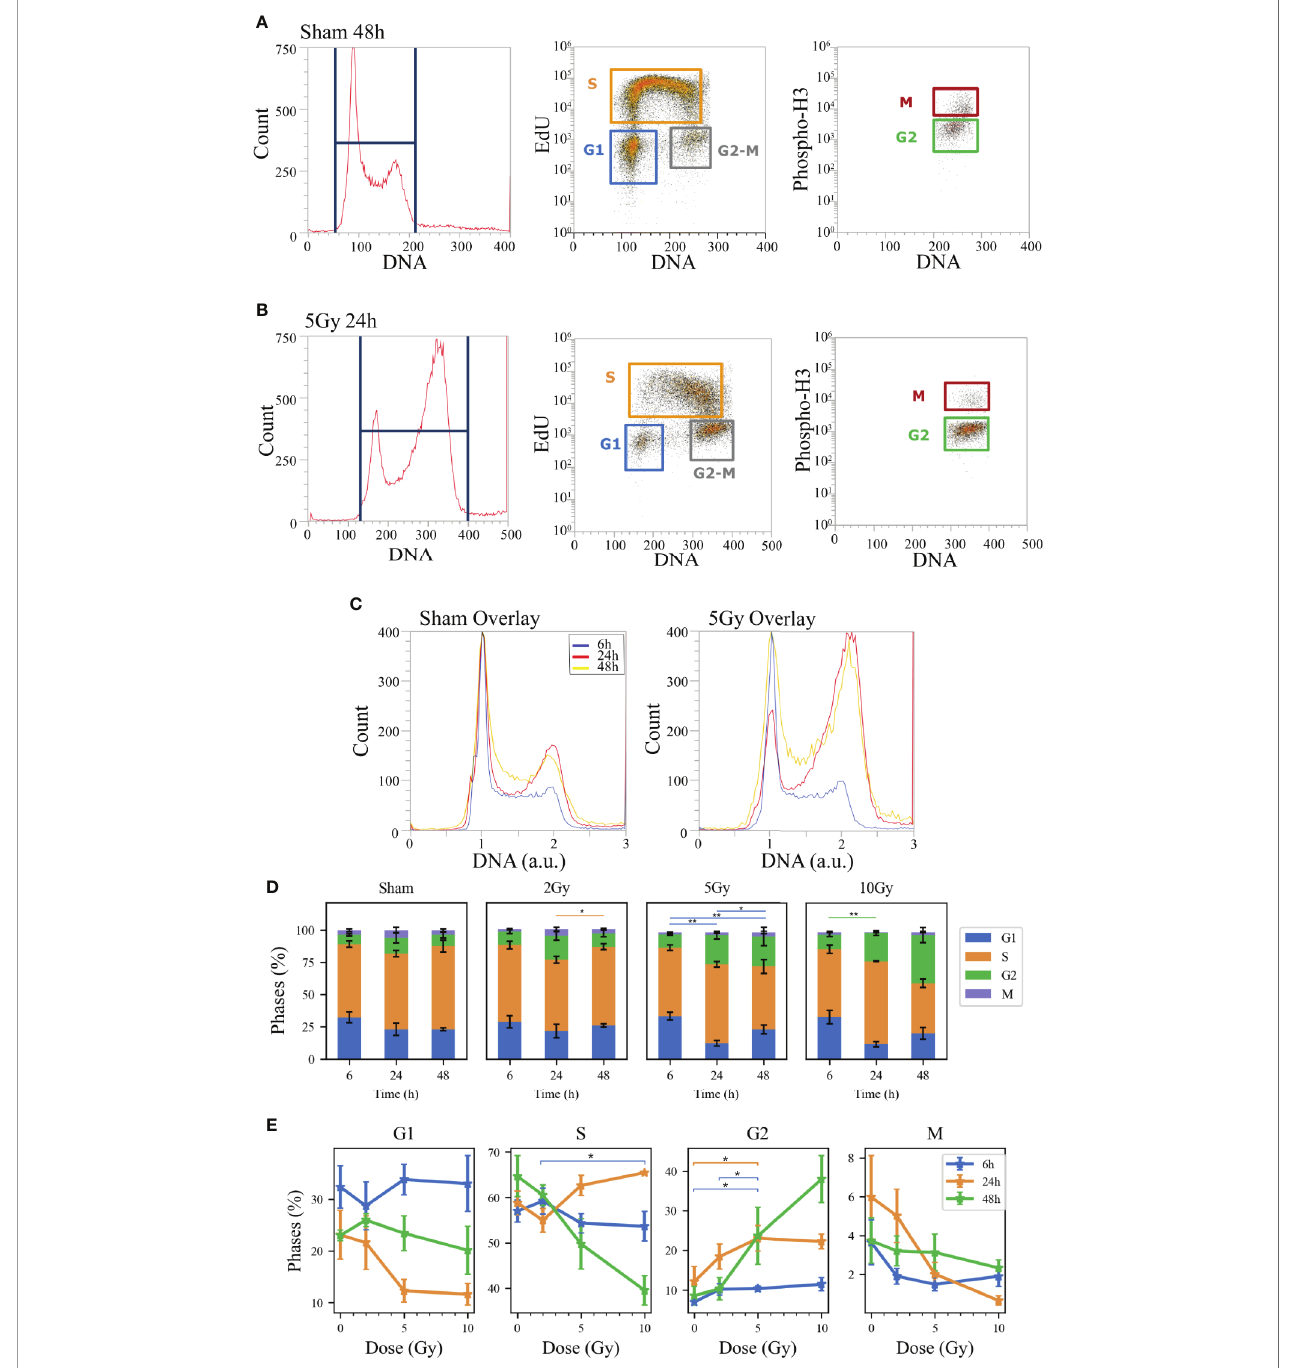
FIGURE 3 | Cell cycle analysis with fl ow cytometry following the “ Treat + Seed ” protocol. Hierarchical gating strategy for the distribution of Caco-2 cells in the cell cycle demonstrated with illustrative data for: (A) Sham condition at 48 h; (B) 5-Gy-irradiated cells at 24 h. From left to right in both panels: monoparametric distribution of FxCycle violet signal with gate on all cells; biparametric plot of EdU vs. FxCycle signals for all cells with gates on G 1 , S and G 2 /M phases; biparametric plot of Phospho-H3 vs. FxCycle signals for all G 2 /M cells with gates on G 2 and M phases. (C) Illustrative relative DNA content distributions for the whole cell population (average FxCycle signal for cells in G1 normalized to 1) for the sham (left) and 5-Gy condition (right) overlayed at different time points. (D) Percentages of cells in G 1 , S, G 2 and M for the different irradiation conditions as a function of time. (E) Percentages of cells in each phase for the different time points as a function of X-ray dose (same data as in panel D, lines are a guide to the eye). Data are mean ± SEM, obtained from ≥ 3 independent experiments. Statistical signi fi cance (post-hoc pairwise comparisons with Bonferroni correction) is as follows: *p < 0.05, **p <